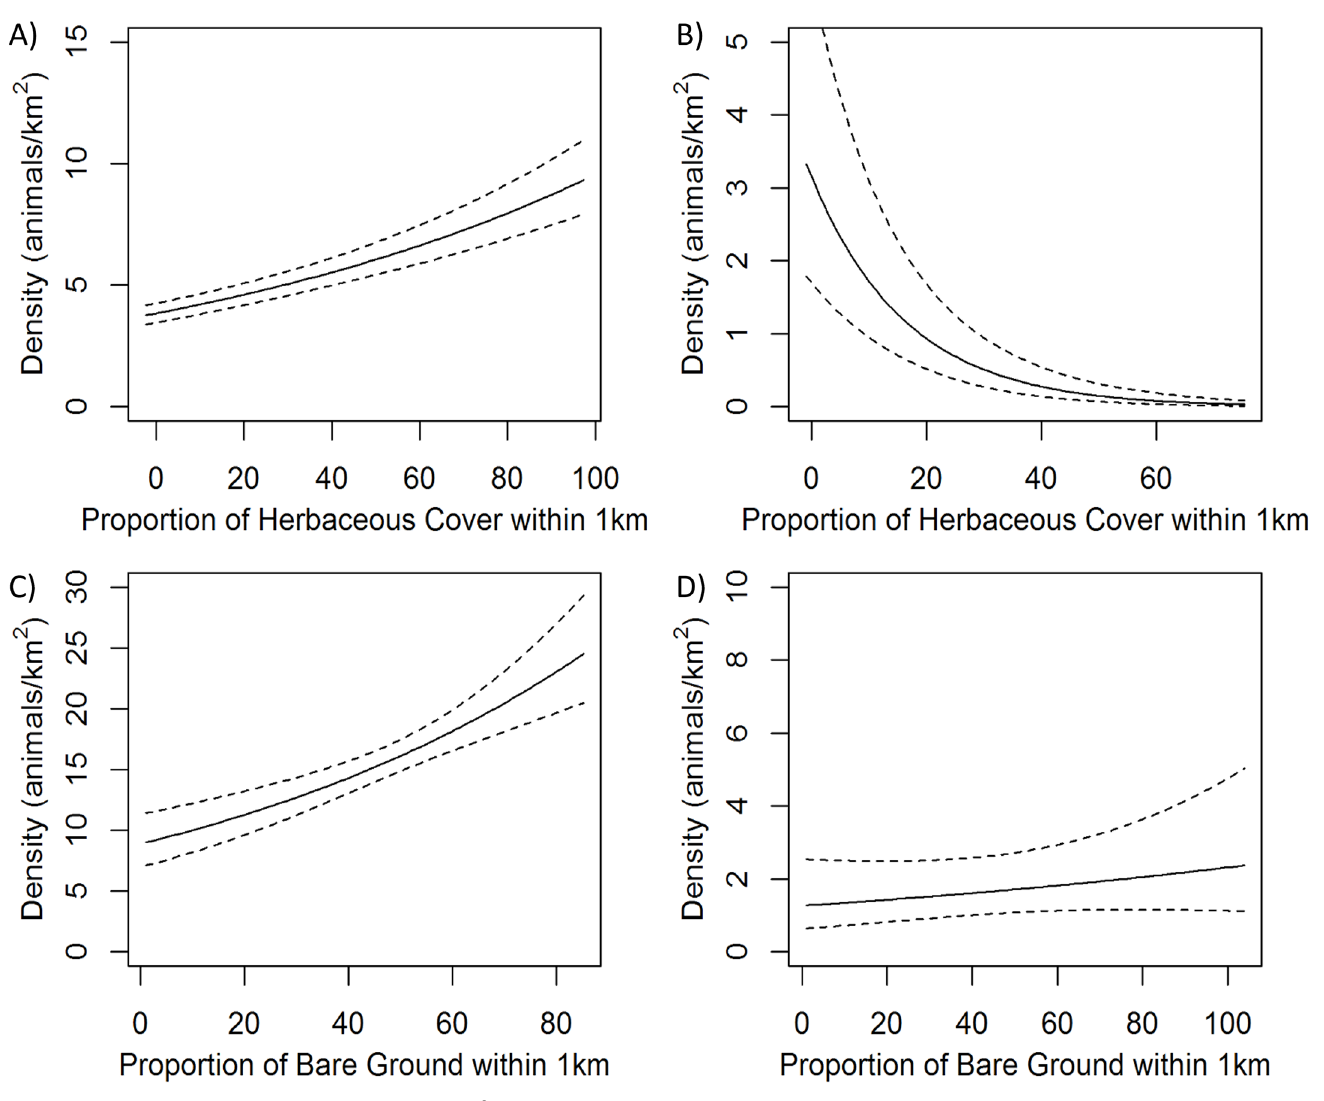
Fig 4. Modeled response of density (individuals/km 2 ) of small mammalspecies groups to proportion of herbaceous cover or bare ground. Top panelsshow herbaceouscover, bottom panelsshow bare ground; dotted lines show 95% confidenceinterval. Panel A) shows white-tailed prairie dogs, B) least chipmunks,C) Wyoming groundsquirrels, and D) leporids( Sylvilagus sp. and Lepus townsendii